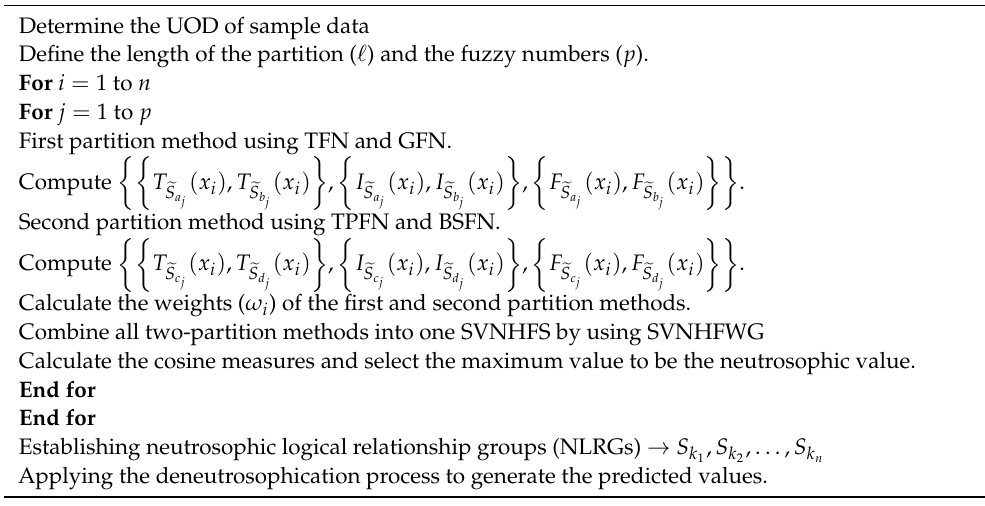
Algorithm 1. Pseudo code for the GBMF-SVNHFTS